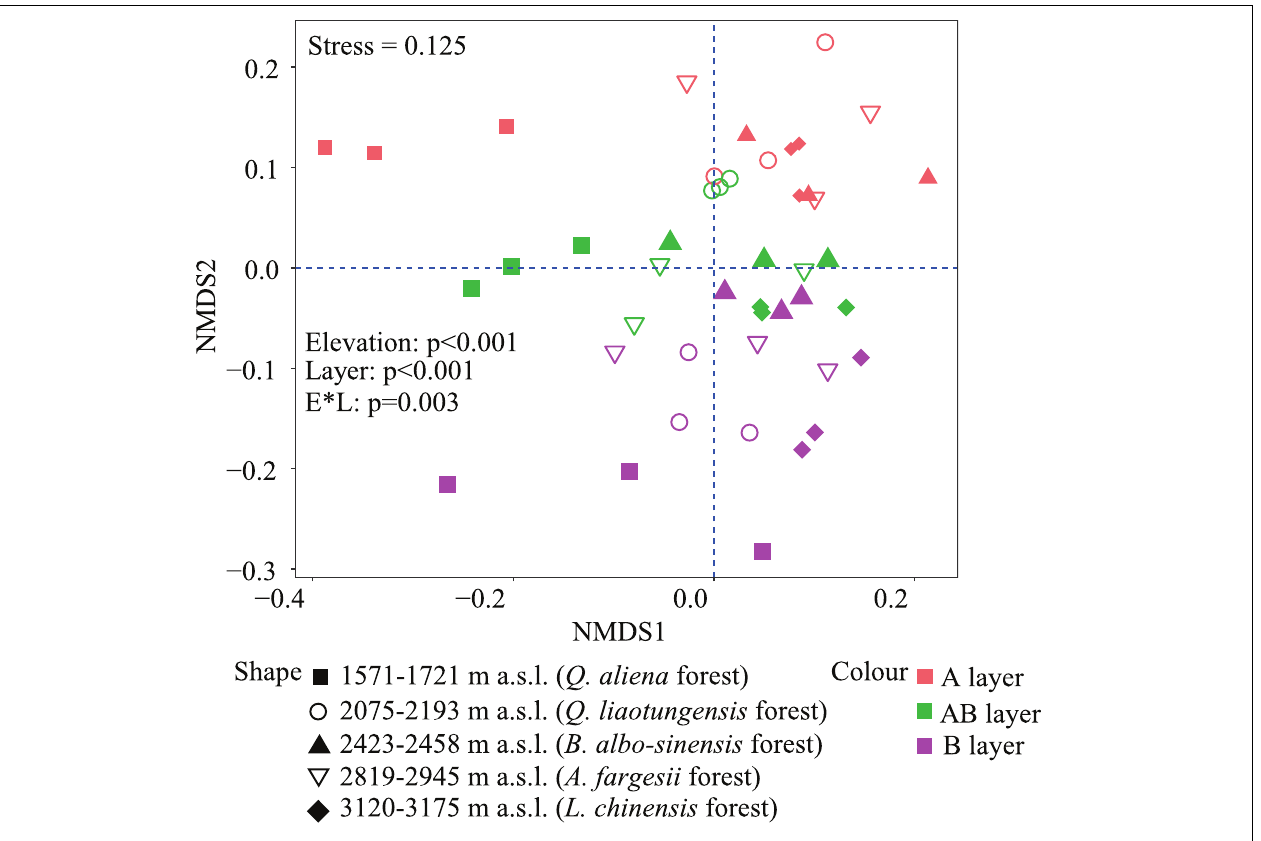
FIGURE 2 | Non-metric multidimensional scaling (NMDS) of soil bacterial community based on weighted UniFrac distances derived from OTU composition. OTUs, operational taxonomic